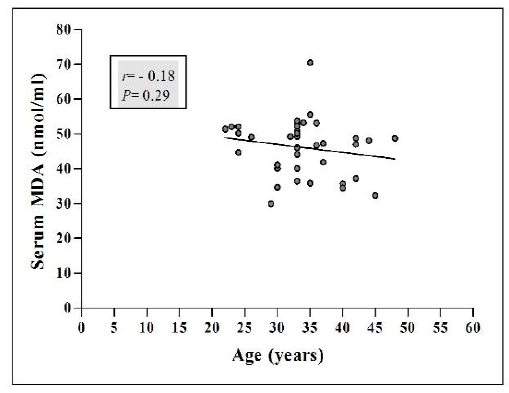
Figure (7): Correlation between the age of painters and their serum levels of MDA. n = 37 subjects; r : Pearson’s correlation coefficient